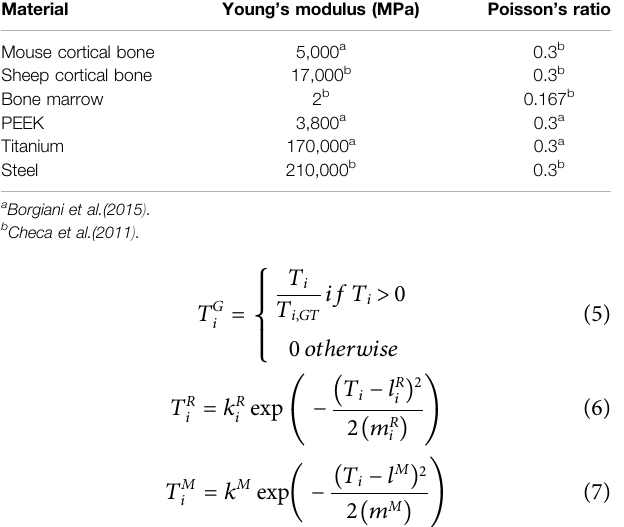
TABLE 2 | Material properties of the fi xators, screws and non-regenerating tissues.